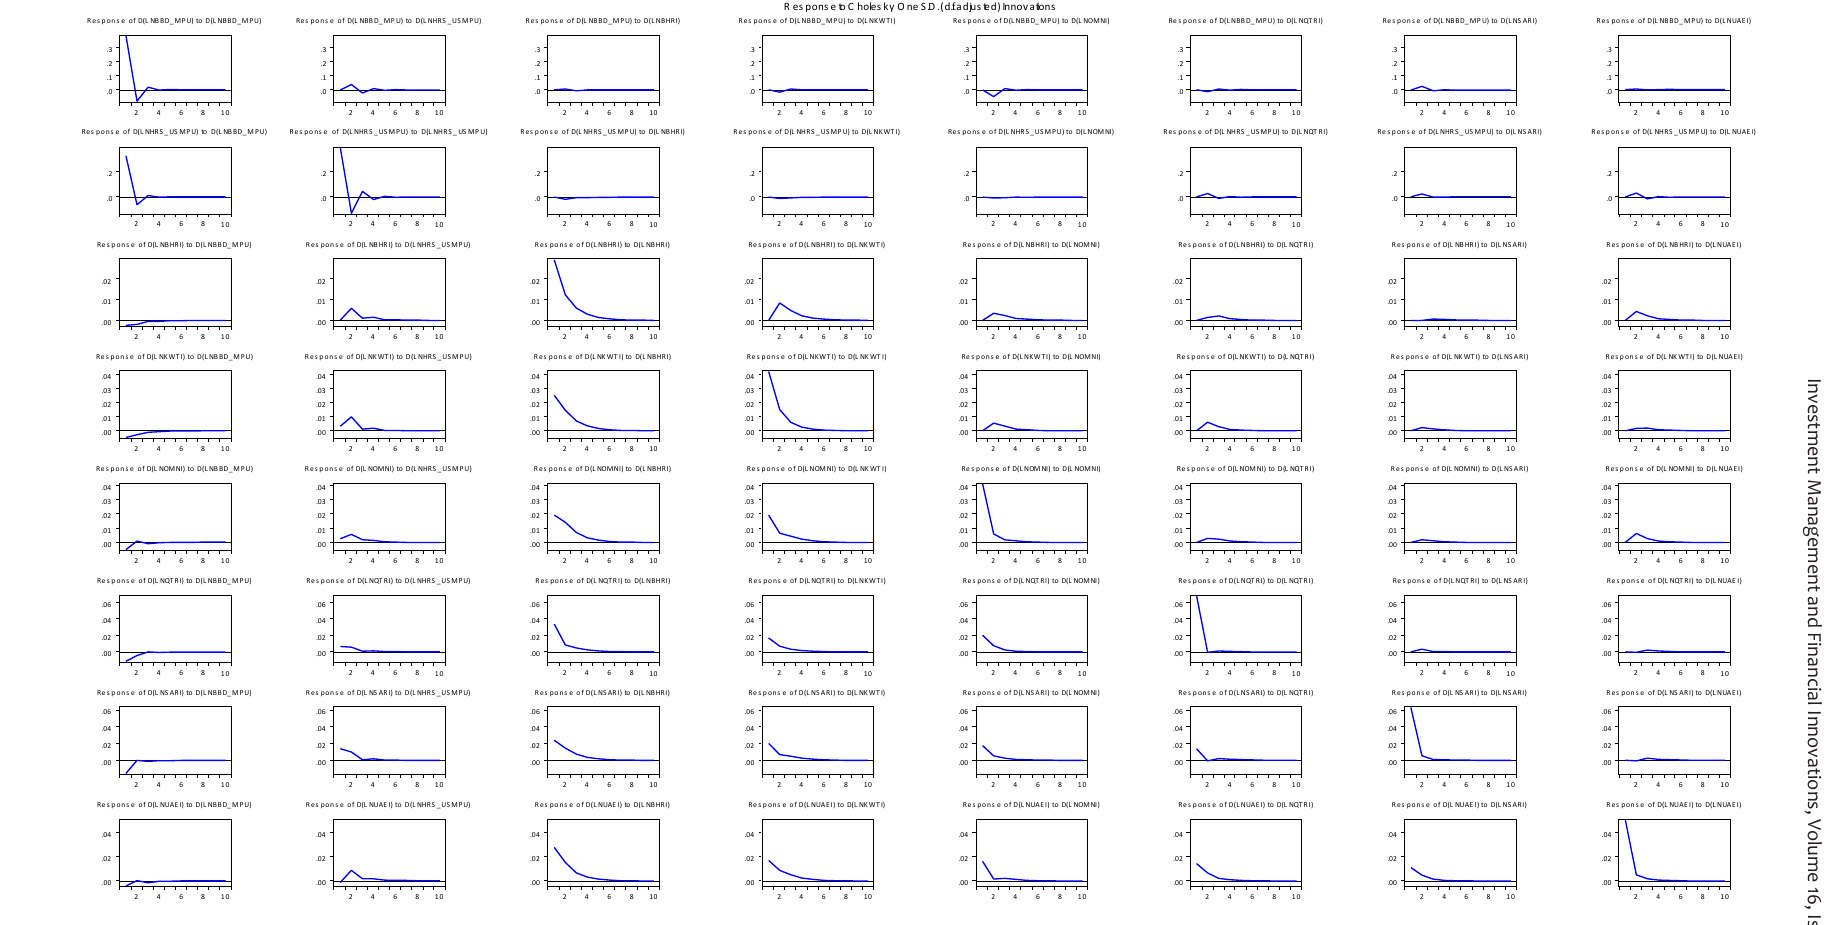
Figure 4. Impulse Response Function with Cholesky